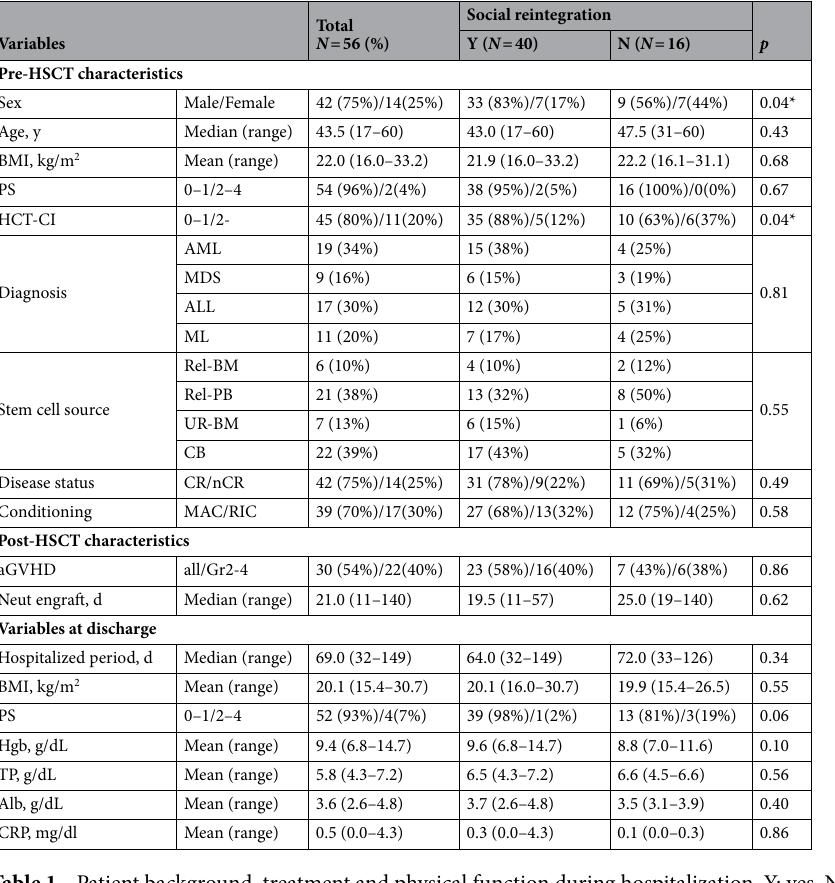
Table 1. Patient background, treatment and physical function during hospitalization. Y; yes, N; no, HSCT; hematopoietic stem cell transplantation, BMI; body mass index, PS; performance status, HCT-CI;